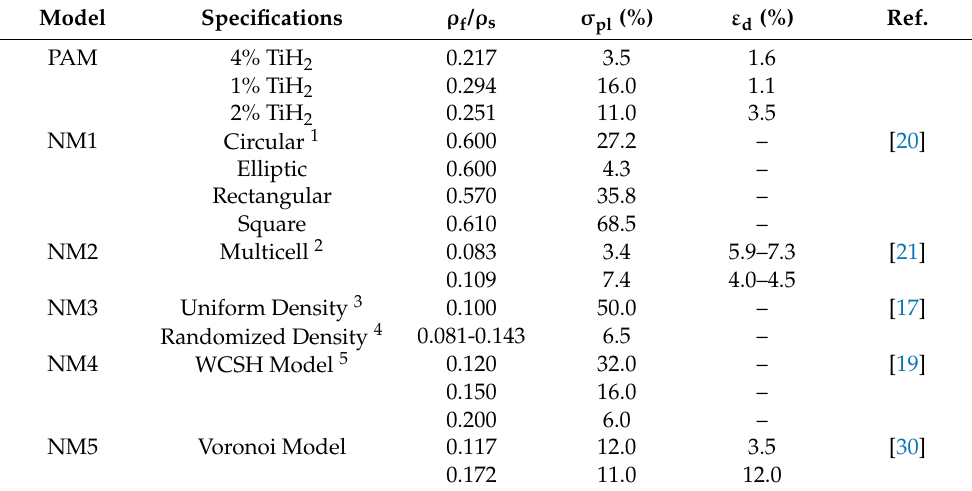
Table 7. Comparison of accuracy in compressive parameters simulation: proposed analytical model vs. numerical models from the